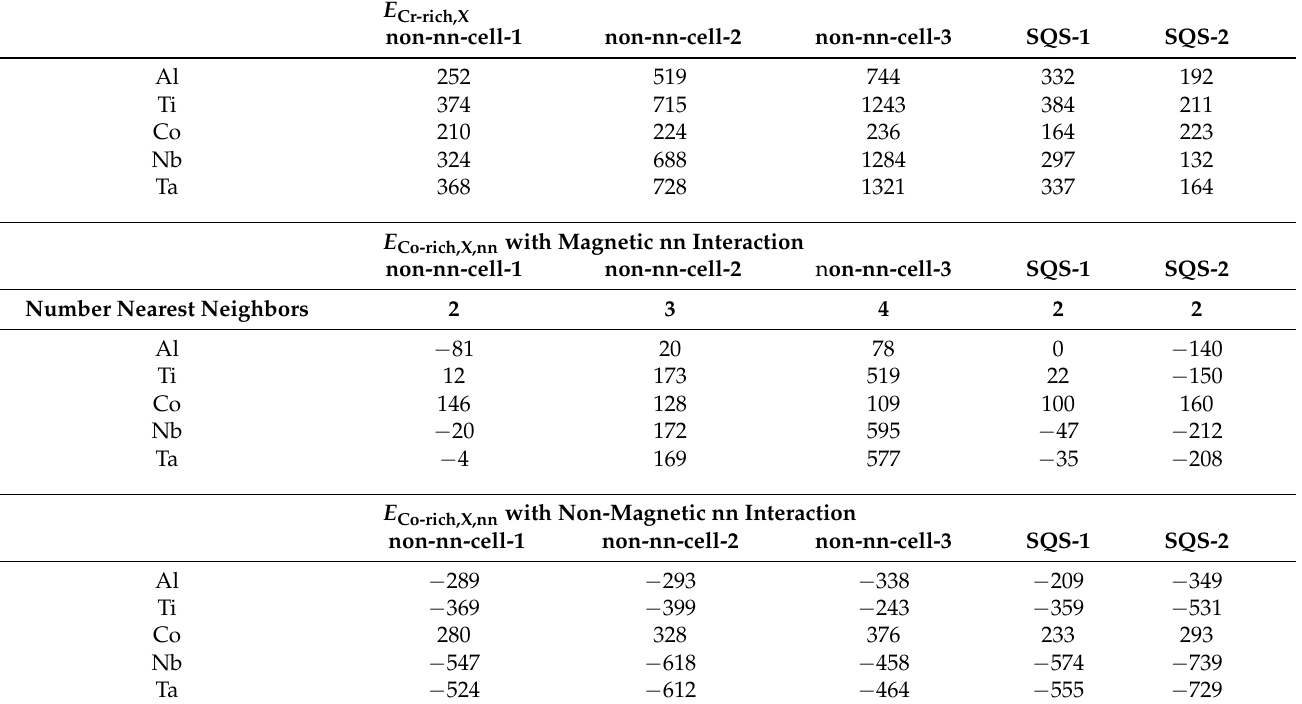
Table 4. The transfer energy for an element between a pure nickel matrix and a Ni 25 Cr 6 X cell. The first sub-table shows the transfer energy E Cr-rich,X itself. The second sub-table shows the number of nearest neighbours in each cell and the energy E Cr-rich,X, nn that accounts for nearest-neighbor effects, using the magnetic interaction energy from Table 3. The third sub-table shows E Cr-rich,X, nn when using the non-magnetic interaction energy. Detailed explanation in the text. All energies are given in